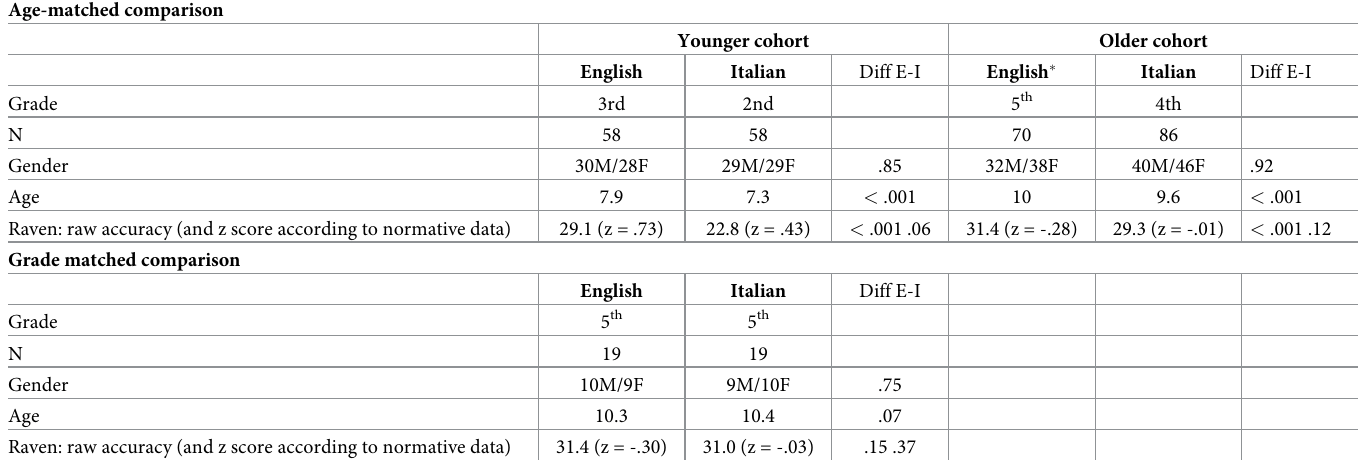
Table 1. Demographic characteristics of the groups of participants involved in the